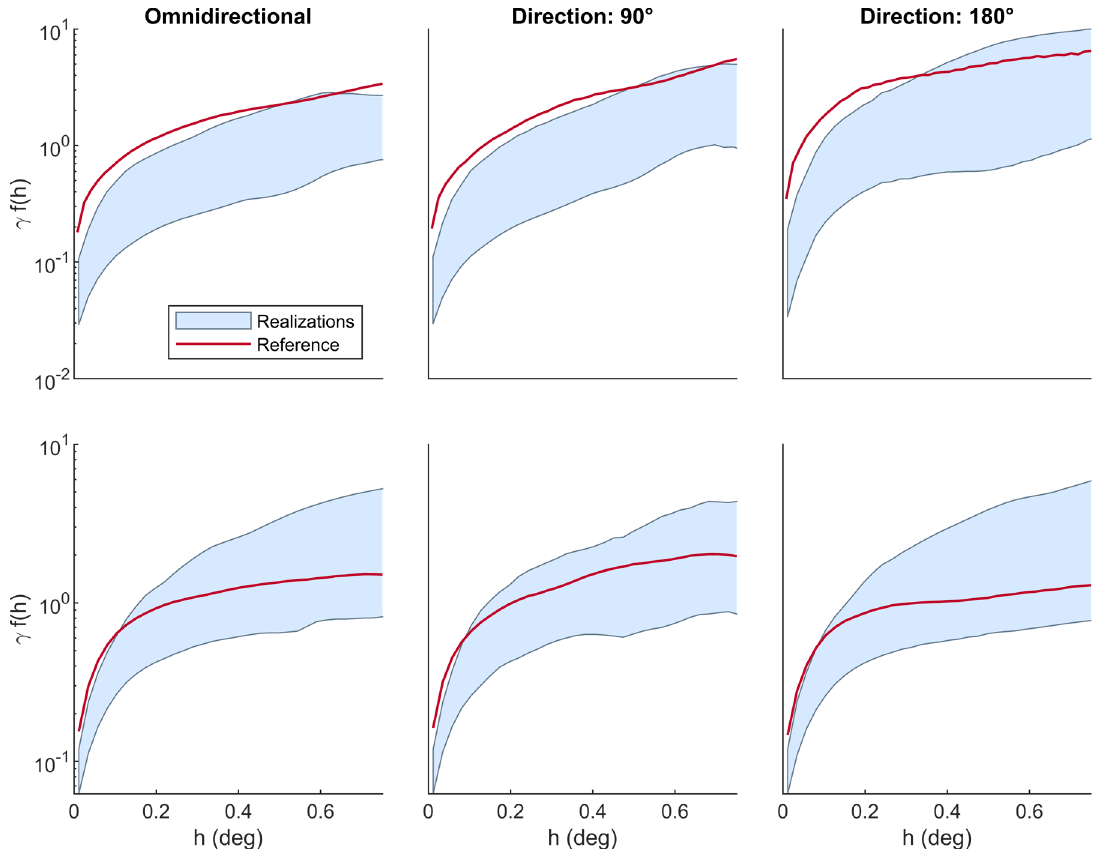
Figure 8. Experimental omnidirectional and directional (along 90 ° and 180 ° directions) variograms for the reference and 5%–95% envelope of 50 realizations on 10 June 2017 (first row) and 15 June 2017 (second row).